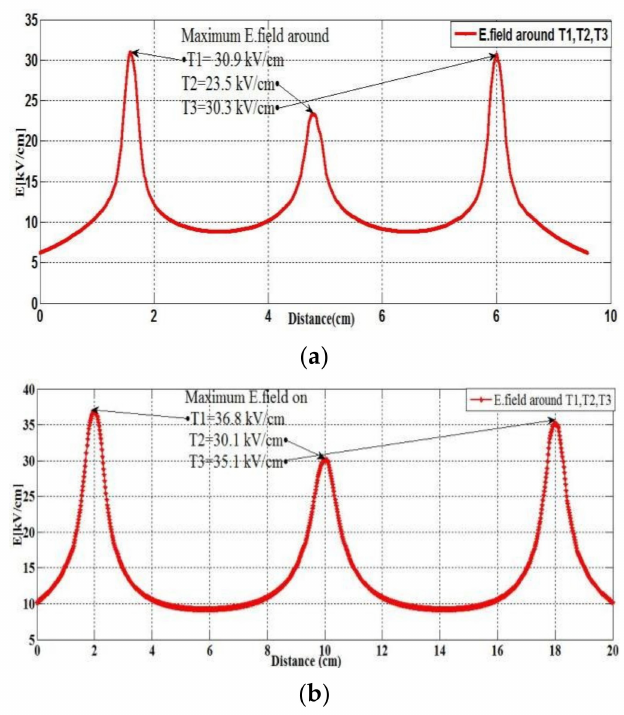
Figure 6. Electric field distribution with ( a ) and without upward leader inception ( b ).